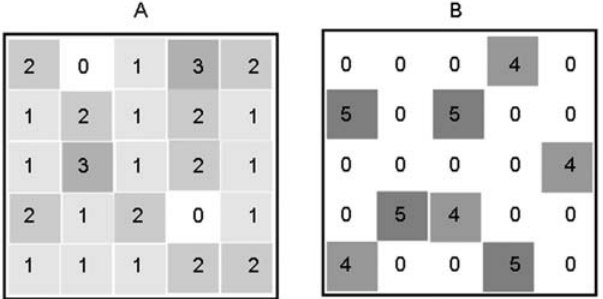
Figure 1. Predicted distribution of total investment. The same total investment (sum of cell values) into a resource landscape with (A) uniformly low risk where investment is evenly spread among options or (B) uniformly high risk with distinct investment peaks (B). Higher number and darker colour indicate a higher local investment.